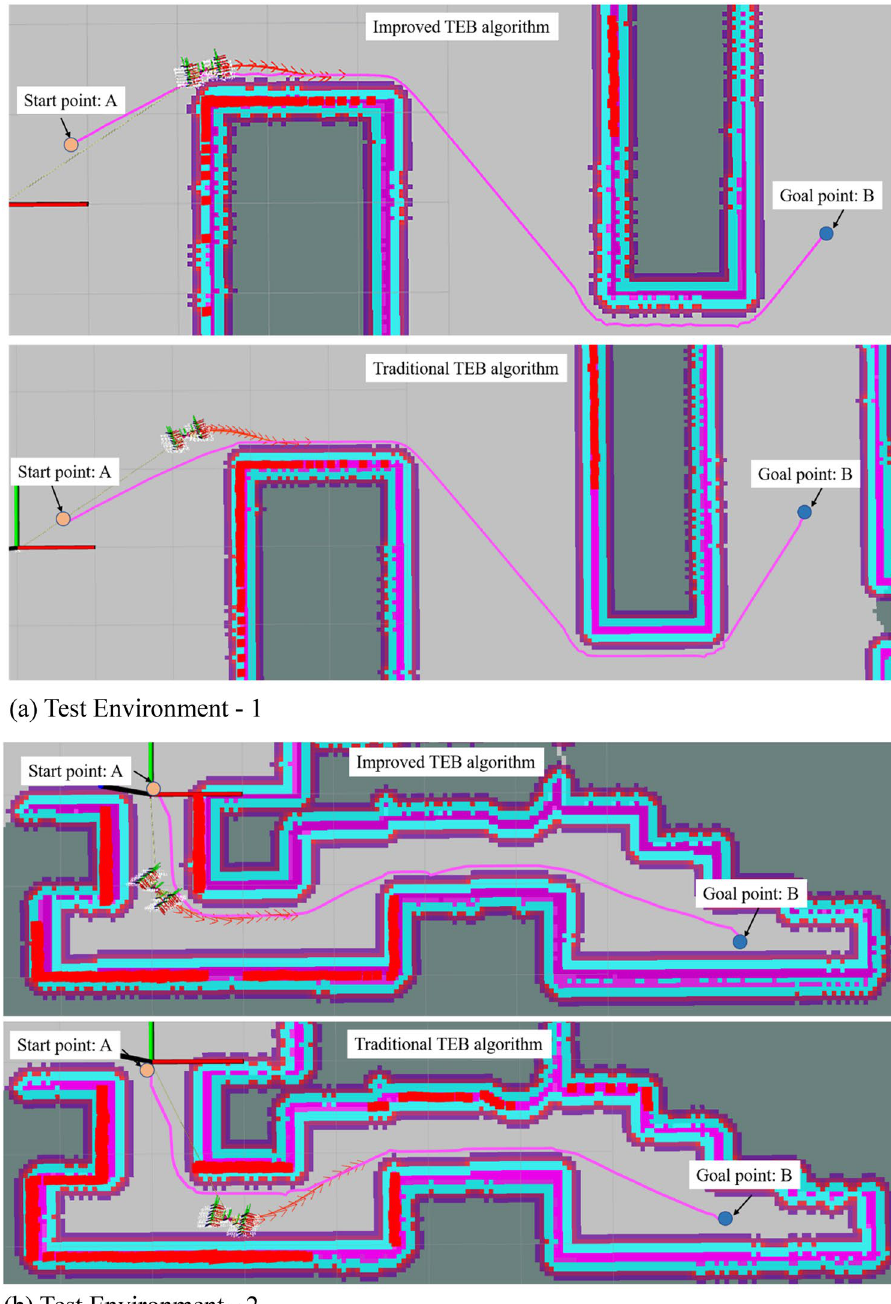
Figure 11. Test environments for robots.